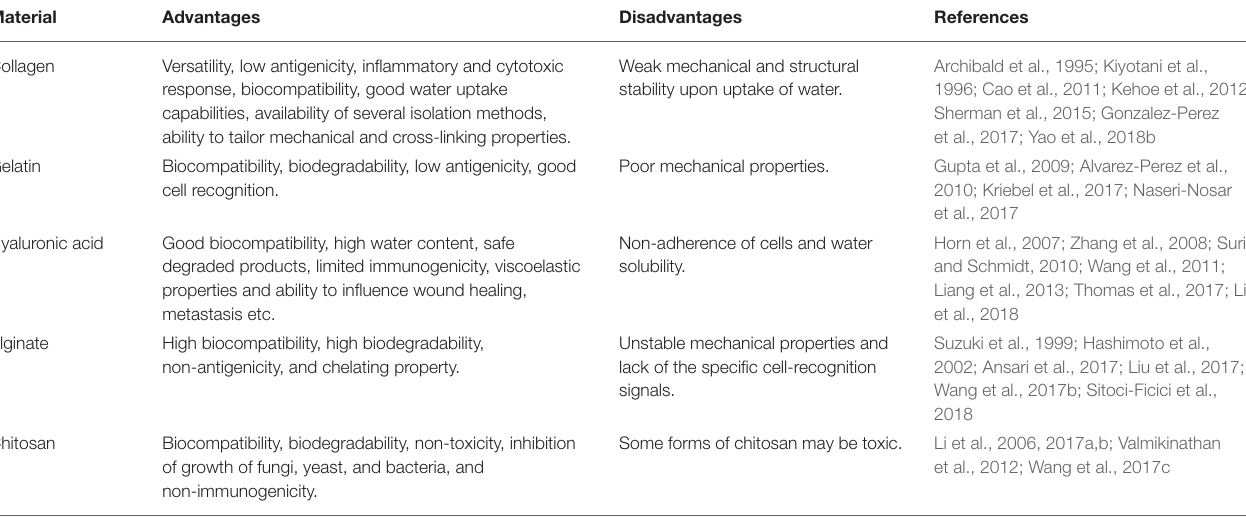
TABLE 1 | Advantages and disadvantages of natural